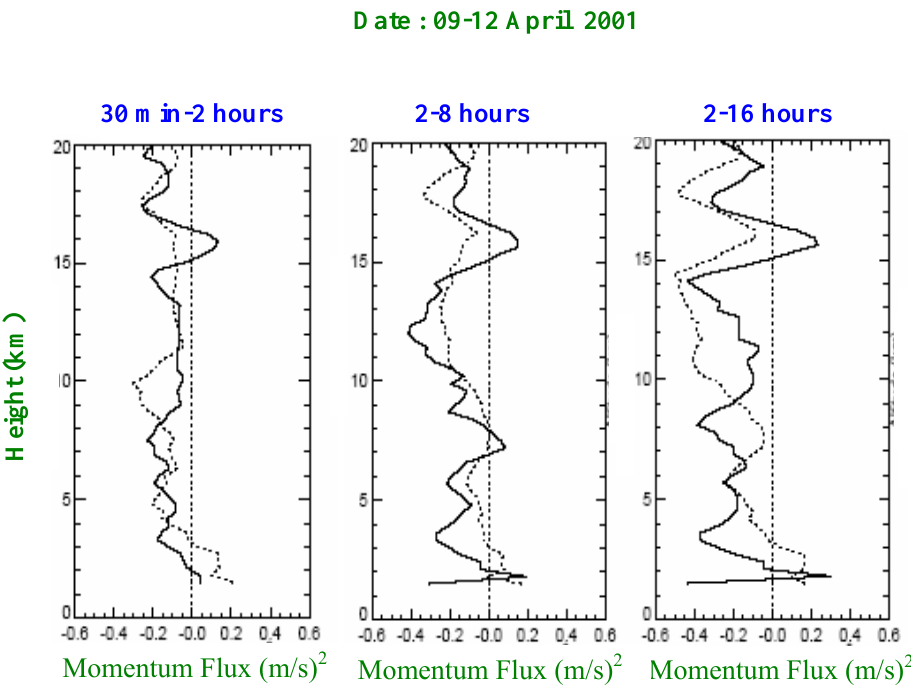
momentum flux. Zonal fluxes are small at lower levels and increasingly negative (westward) at higher heights for both shorter and longer periods. The dominant contributions to